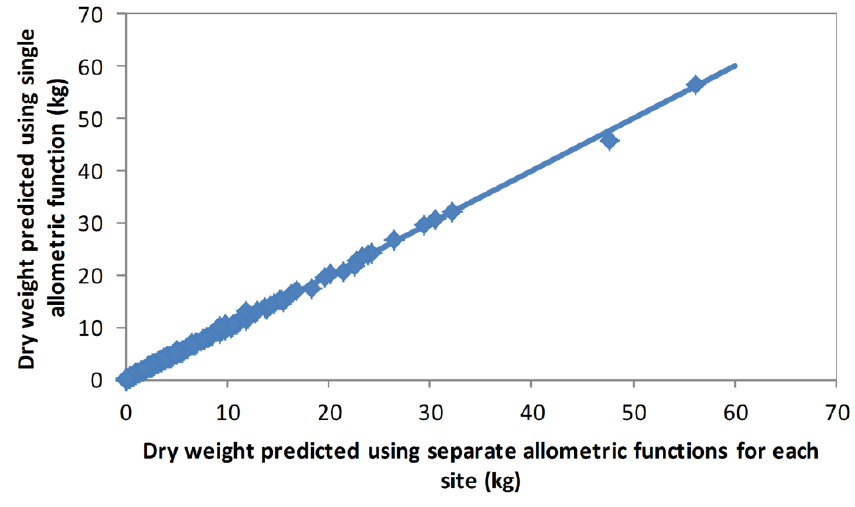
Figure 2. Oven dry weights of individual shrubs estimated using a single allometric function developed from the combined biomass data, and using allometric functions developed separately for the Oxford and d’Urville biomass